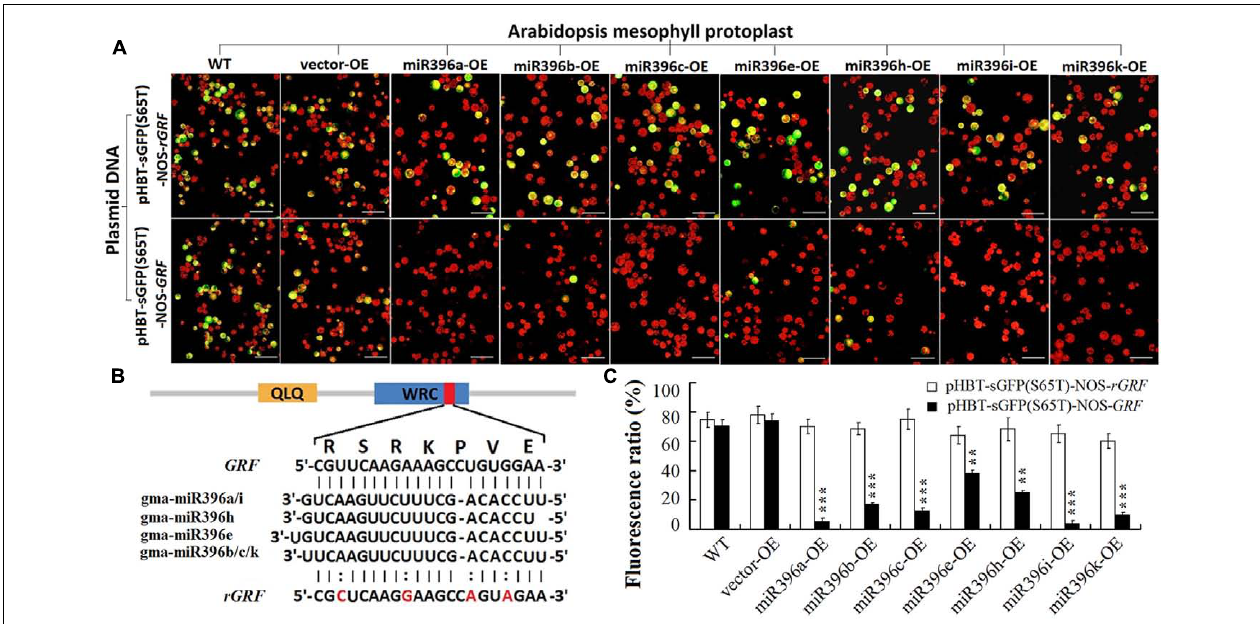
FIGURE 3 | Cleavage of 20 GmGRFs by any one of gma-miR396a/b/c/e/h/i/k verified by improved mesophyll protoplast transient transfection technique. (A) Plasmid DNA of control vector [HBT-sGFP(S65T)-NOS- rGRF ] transfected into mesophyll protoplasts (derived from WT, vector-OE, and each of miR396a/b/c/e/h/i/k-OE transgenic Arabidopsis ) resulted in strong green fluorescence; plasmid DNA of interaction vector [HBT-sGFP(S65T)-NOS- GRF ] transfected into same mesophyll protoplasts resulted in weaker green fluorescence. (Bar = 50 µ m). (B) Interaction between gma-miR396a/b/c/e/h/i/k and GRF/rGRFs : 20 GmGRFs contained predicted cleavage site of gma-miR396a/b/c/e/h/i/k. rGRF contained four mutated bases that could not be cleaved by gma-miR396a/b/c/e/h/i/k. (C) Fluorescence ratio of mesophyll protoplast cells. Values are average of three replicates ± SD. Asterisks indicate significant difference applying Student’s t -test ( ∗ P < 0.05; ∗∗ P < 0.01; ∗∗∗ P < 0.001).